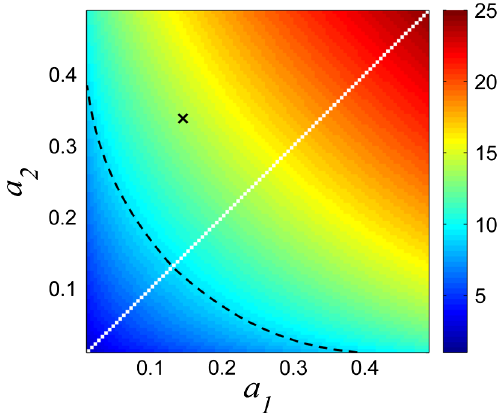
FIG. 2. Maximal peak power j c 12 j 2 max generated by two colliding ABs as a function of their governing parameter a . Note that 1 < j c 12 j 2 max < 25 . j c 12 j 2 max ¼ 1 corresponds to the background power (i.e., the plane wave). The highest limiting case j c 12 j 2 max ¼ 25 corresponds to the collision of two Peregrine solitons (i.e., the second-order rational soliton). The dashed black line matches j c 12 j 2 max ¼ 9 , which is the peak power of the Peregrine soliton. The black x corresponds to the physical parameters used in the